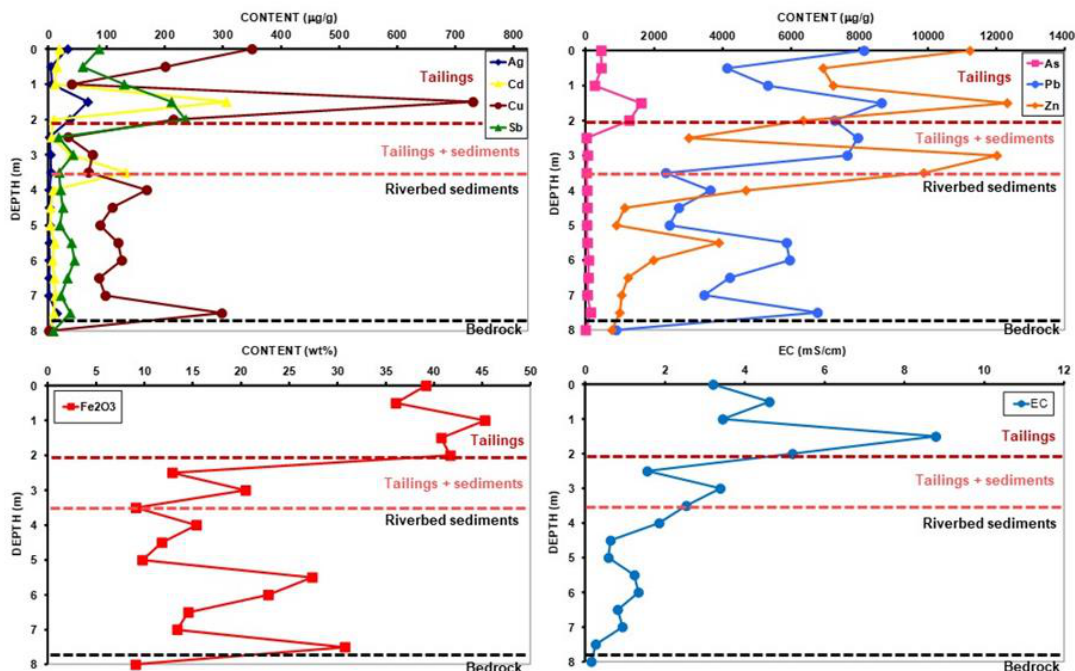
Figure 5. Distribution-with-depth profiles for total ferric iron and trace element concentrations from Las Matildes borehole samples.